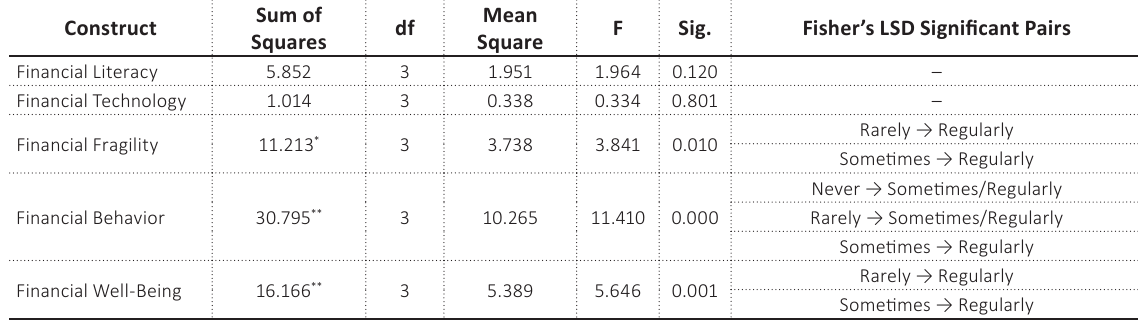
Note: * indicates significance at the 1% level. ** indicates significance at the 0.1% Table 16 indicates that financial fragility, behavior and well-being scores are statistically significant across the four groups, whereas financial literacy and financial technology is not significant. Fisher’s